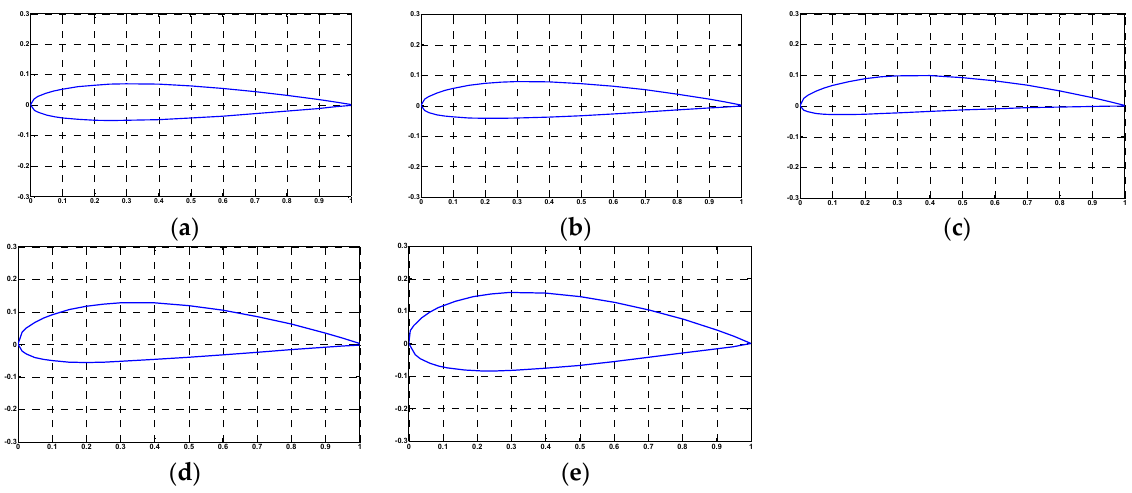
Figure 5. Profile of NACA airfoils ( a ) NACA1412, ( b ) NACA2412, ( c ) NACA4412, ( d ) NACA4418, and ( e ) NACA4424.